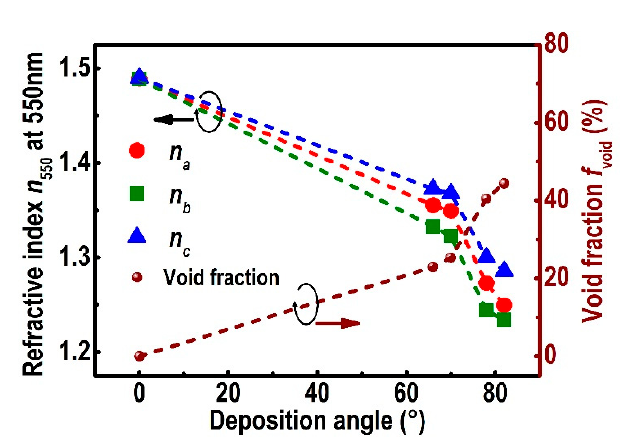
Figure 8. Void fractions and principal refractive indices n a (red dots), n b (green squares), and n c (blue triangles) at 550 nm for the YF 3 columnar films grown at various deposition angles. Dashed lines are guides for the eye.